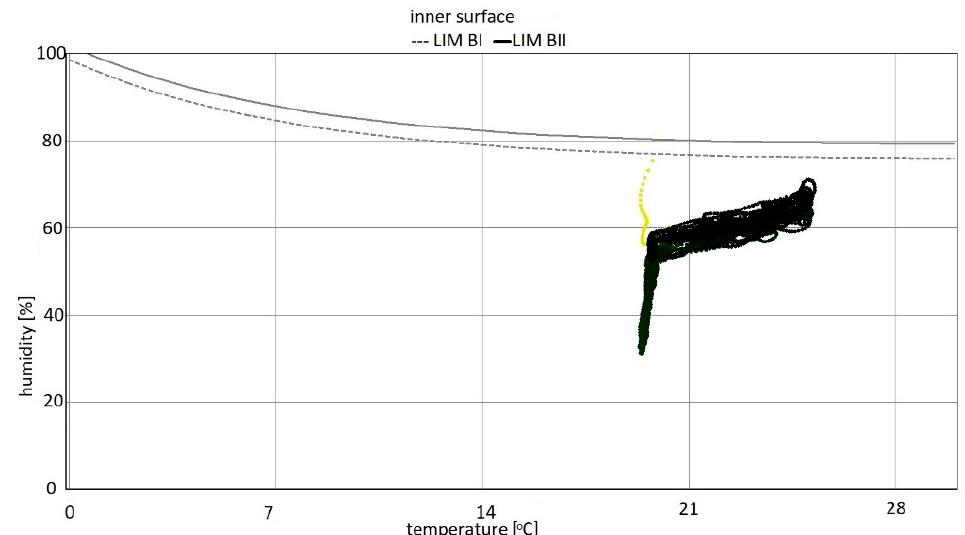
Figure 14. Isopleth of the inner surface of the partition, variant 4 [70].